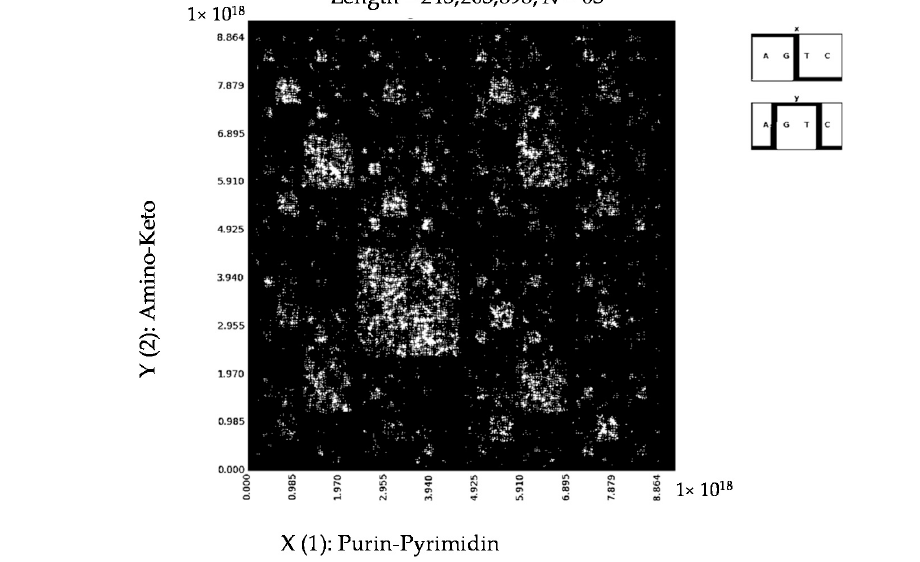
Figure 10. The binary mosaics of the first 15,000,000 nucleotides of the sequences of Homo sapiens chromosomes X and Y (two upper levels) and Homo sapiens chromosome 1 in the case of their division into 63-plets. Two symbols are shown at the right side of each pattern to indicate what kinds of the sub-alphabets from Figure 2 were used to construct the pattern. Initial data were taken from [41,42].